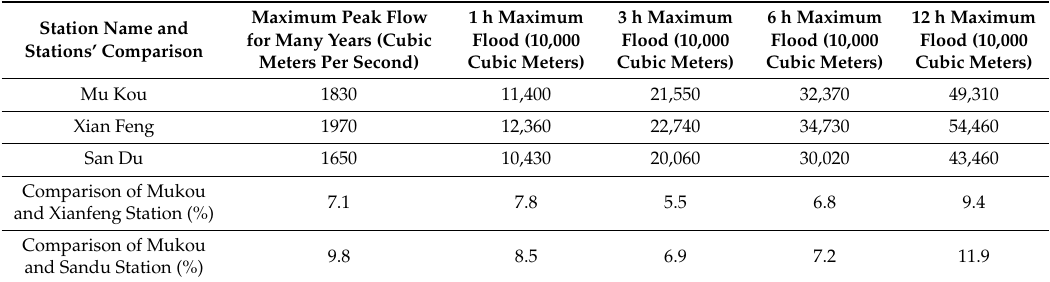
Table 7. Comparison of flood amount